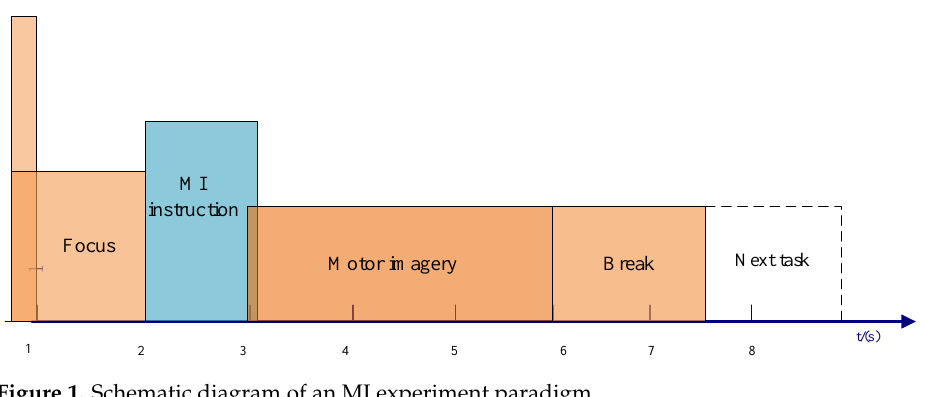
Figure 1. Schematic diagram of an MI experiment paradigm.